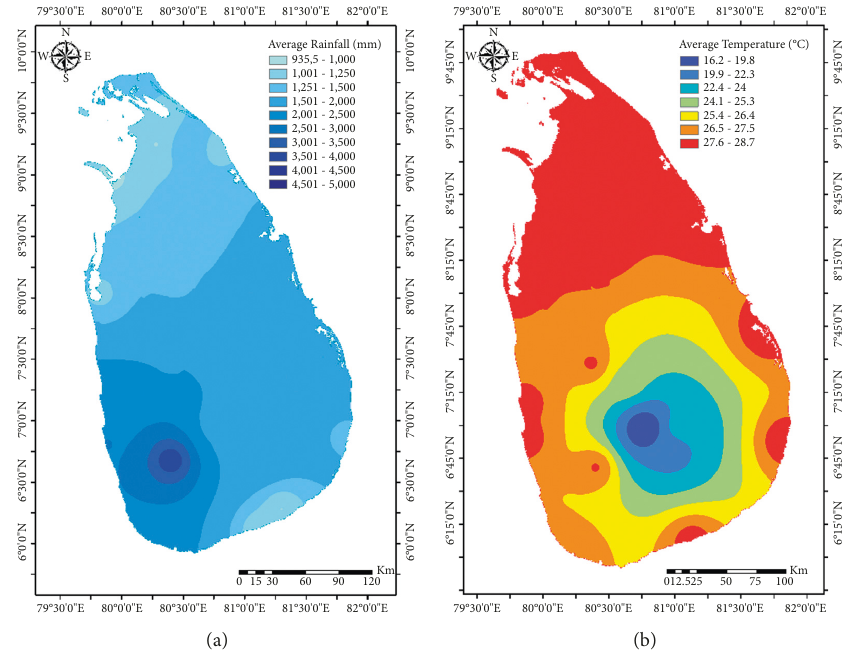
Figure 2: Spatial variation of (a) annual rainfall and (b) annual mean temperature in Sri Lanka.